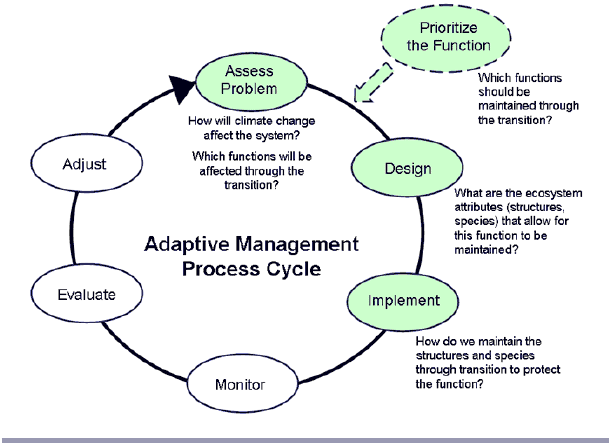
Fig. 1 . Conceptual diagram of the adaptive management cycle using the guided transition approach. Within the adaptive management process cycle, guided transition helps direct the front end decision-making of problem assessment, design, and implementation (green circles) by directing the questions to focus on the functional changes of ecosystem transition through unidirectional climate change. This process also adds a step in prioritizing the functions to protect through the transition (dashed outline), which will help structure the design and implementation of adaptation